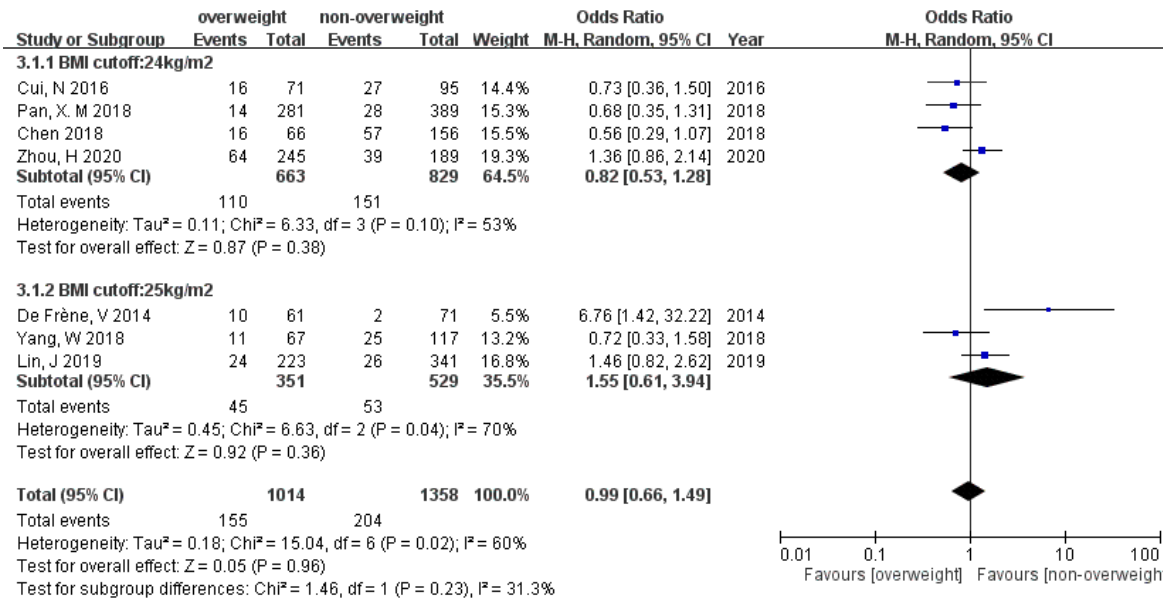
Figure 6. Forest plot of the association between preterm birth and overweightness in women with PCOS.